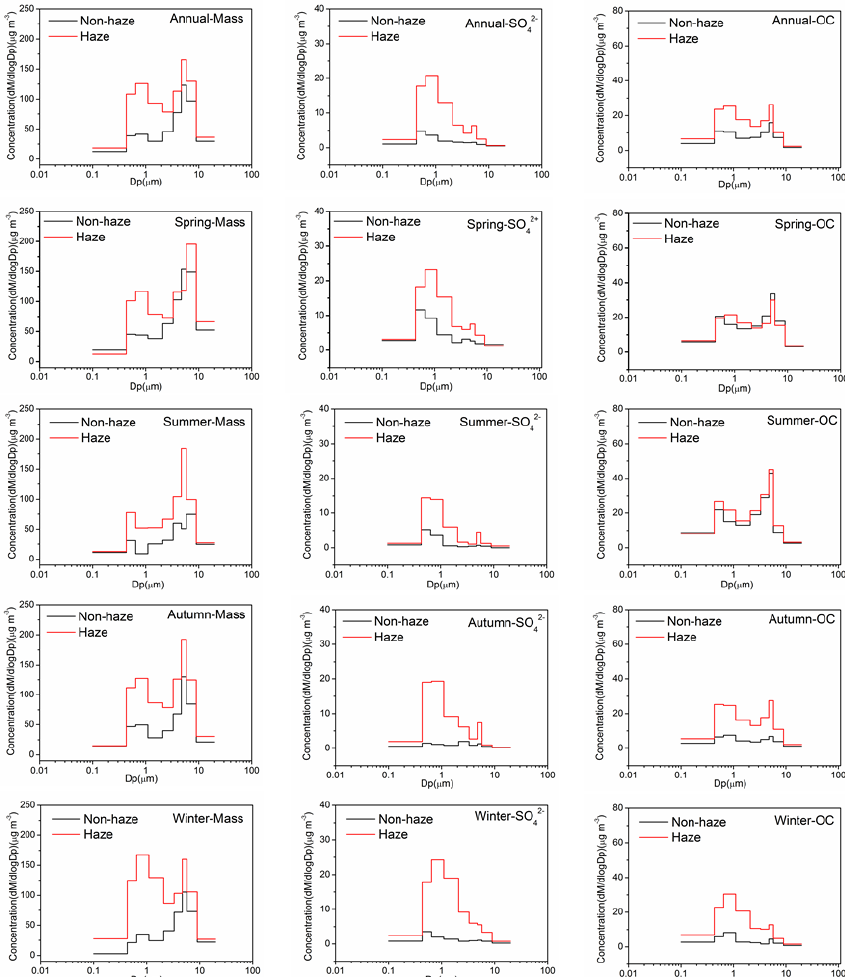
Figure 3. Mass concentration size distributions on haze and non-haze days over the entire sampling period (annual) and by season as well as those of the typical chemical